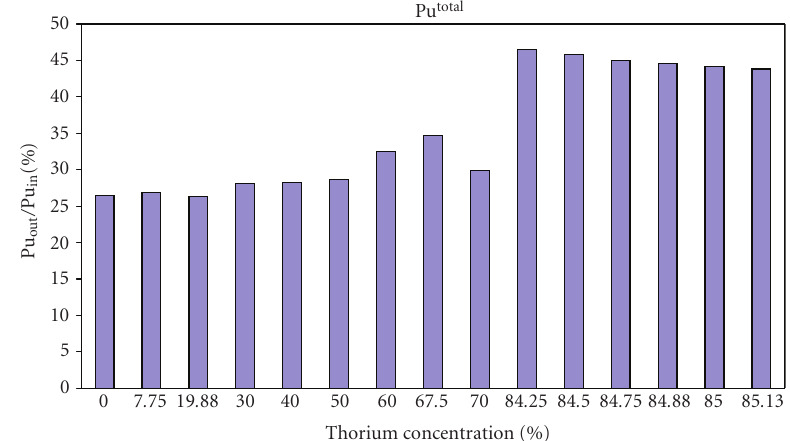
Figure 19: Pu tot out /Pu tot in versus Th